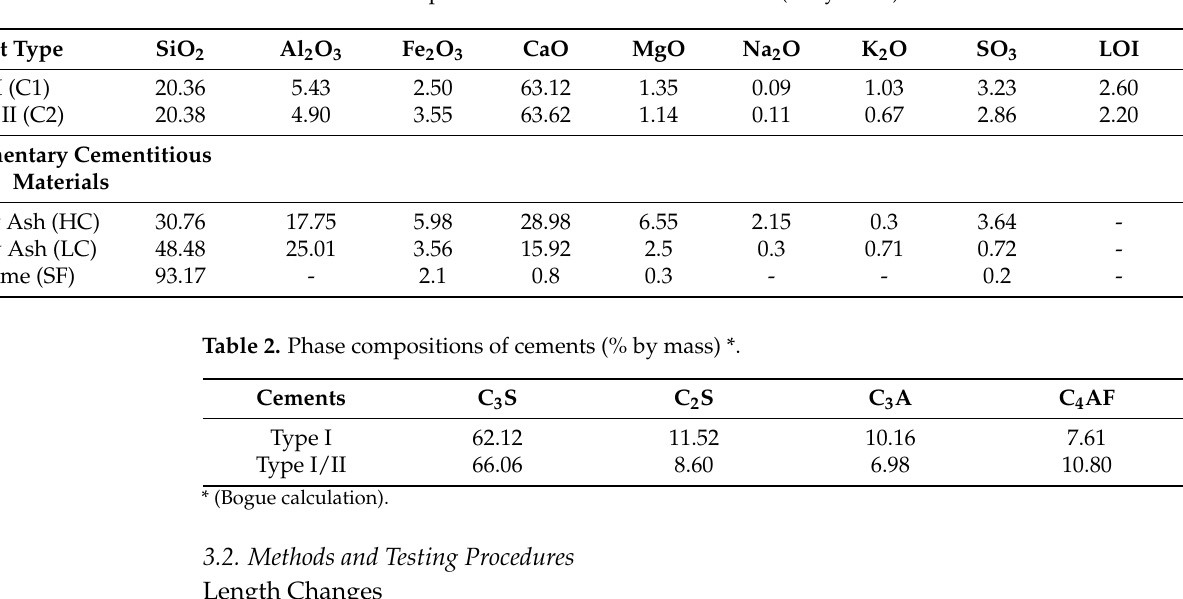
Table 1. Chemical compositions of cementitious materials (% by mass).